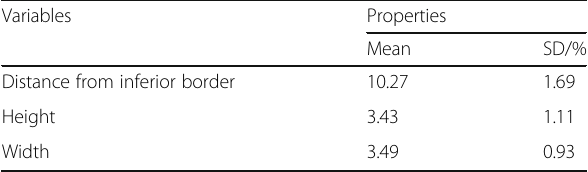
Table 3 Properties of mental foramen irrespective of gender